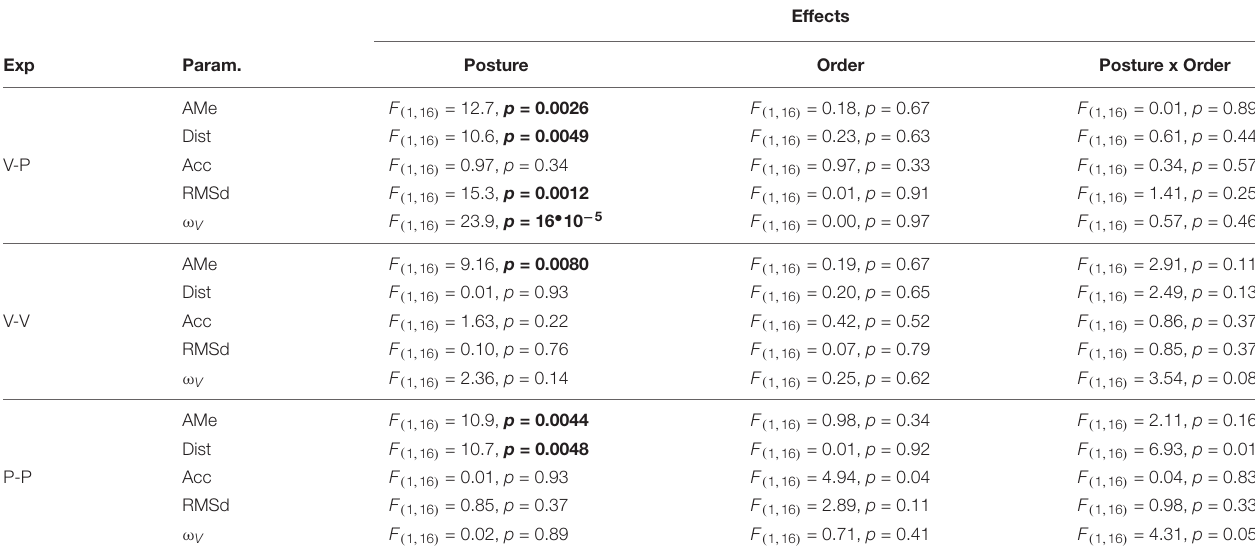
FIGURE 4 | Average subject responses. (A) For the three experiments, the mean orientation of the subjects’ responses to each target orientation is represented for the Seated and Supine conditions. The three parameters representing (B) the response accuracy, (C) Aubert-Müller effects, that is the global bias of the responses due to lateral neck flexion. Positive values correspond to deviations toward the head direction. (D) Response distortions are reported for the Seated and Supine conditions of the three experiments. Vertical whiskers correspond to 95% confidence intervals. ∗ and ∗∗ represent p < 0.05/3 and p < 0.01/3, respectively, and their color represents the experiment to which they refer. TABLE 1 | For each of the experiments (cross-modal, V-P; unimodal visual V-V; unimodal proprioceptive, P-P) the ANOVA main effect of Posture, posture Order and the interaction between these two factors are reported for the Aubert-Müller effect, AMe, the response distortion, Dist, accuracy, Acc, and variability, RMSd, as well as for the relative weight associated to visual information, ω V